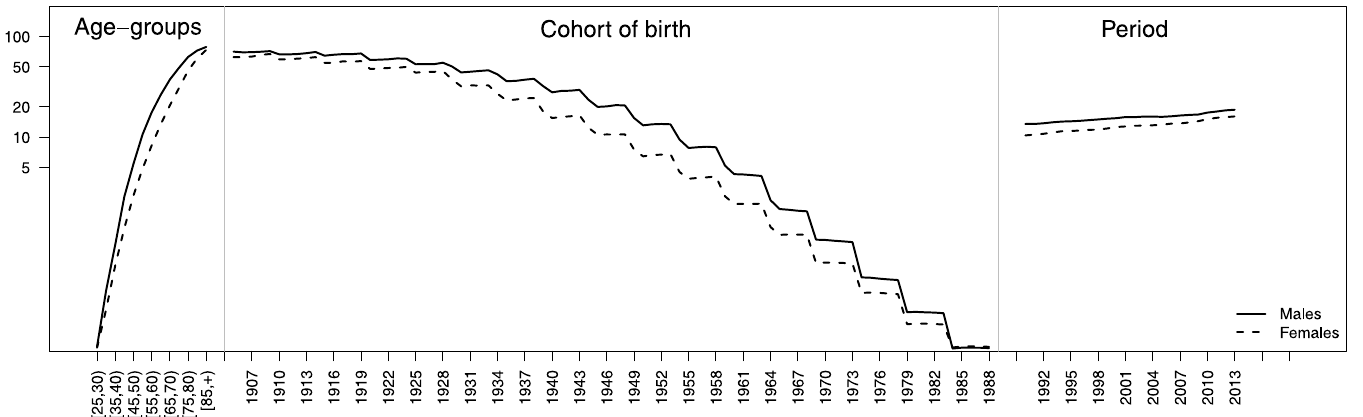
Fig 2. Estimated pancreatic cancer mortality averagerates in whole Spain for males (continuous lines) and females (dotted lines) by age (left), birth cohort (center), and period (right). Posterior medianswere used to compute rates. A semi-logarithmic scale was used on the y axis.